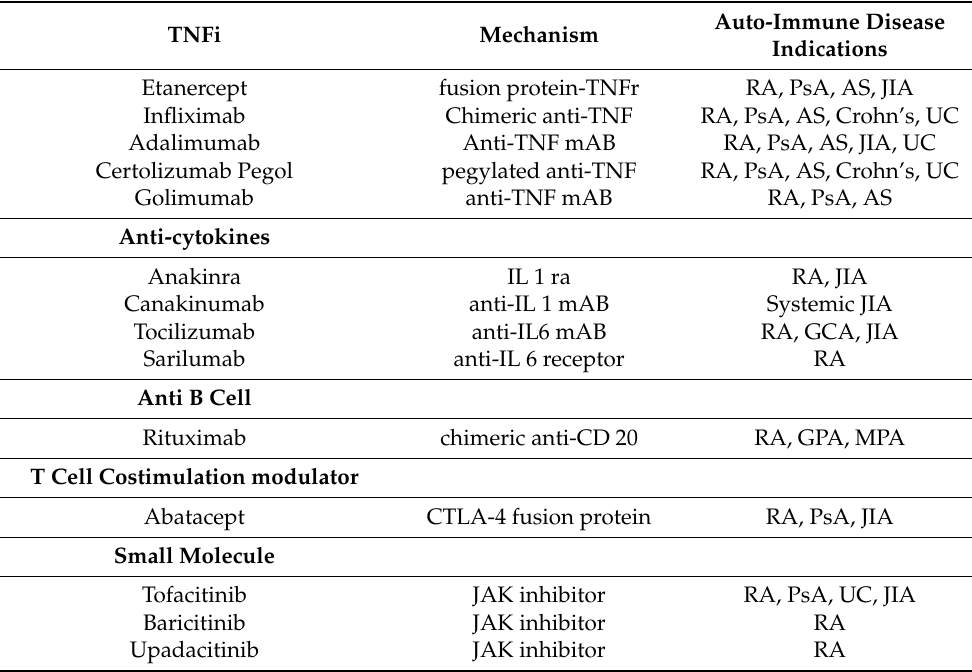
Table 1. FDA approved biologic and small molecule drugs for the treatment of RA diseases and other IMID in the